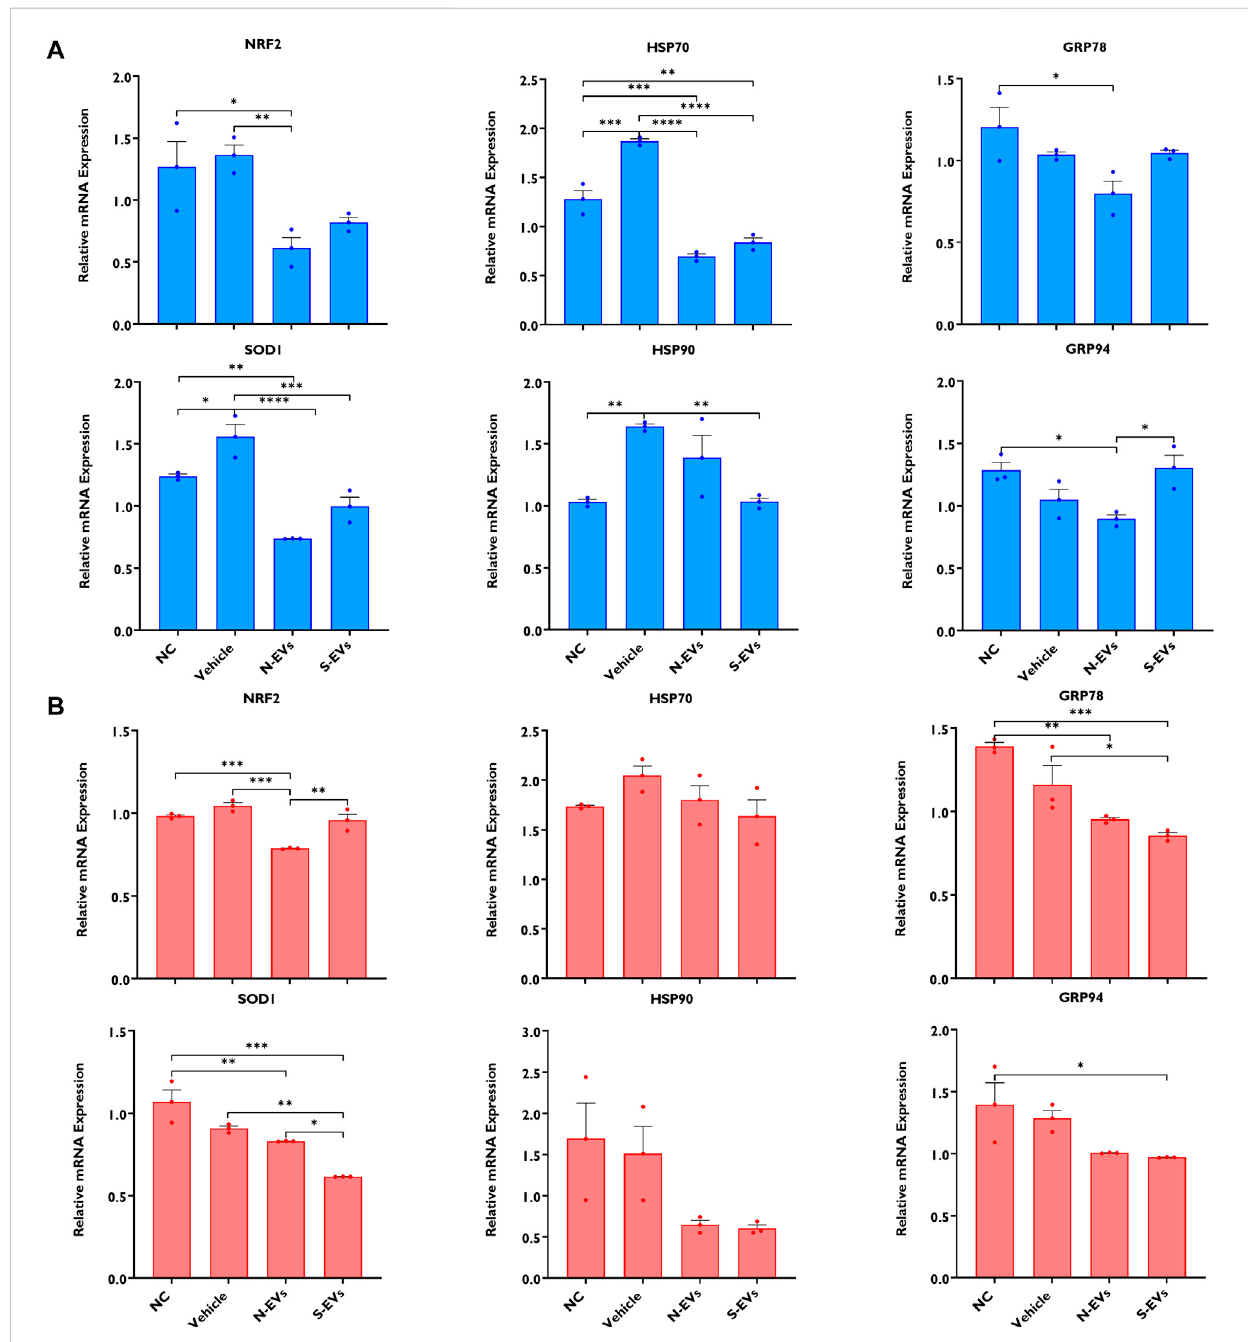
FIGURE 7 The impact of GC-EVs on transcript levels of stress-associated genes in blastocysts derived from oocytes treated with GC-EVs during oocyte maturation at 38.5 ° C (blue) and 41 ° C (red). The expressions of stress-associated genes were signi fi cantly diminished in blastocysts derived from oocytes supplemented with N-EVs and cultured at 38.5 ° C (A) , and similar decreases in gene expression were visualized in blastocysts derived from oocytes supplemented with S-EVs and exposed to HS (B) . Results are from a total of four pools of 5 blastocysts per pool for each treatment. Data represent the mean ± SEM and the differences between means were analyzed using One-way ANOVA followed by Tukey ’ s Multiple Comparisons Test. (* p < 0.05), (** p < 0.01), (*** p < 0.001), (**** p <